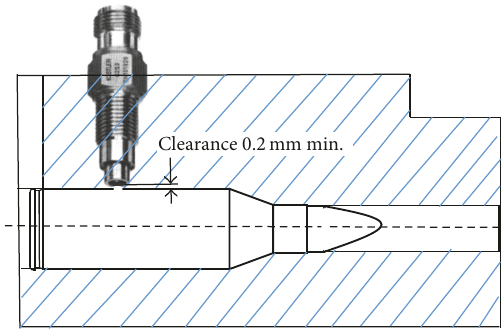
Figure 5: Piezo sensor for cartridge chamber pressure [17].